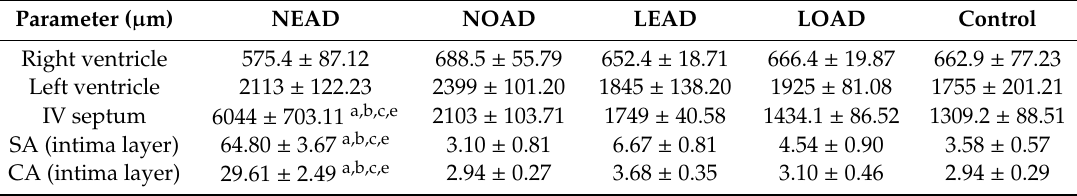
Table 9 . Cardiac and arterial morphometry in the various groups over 60 days of treatment.